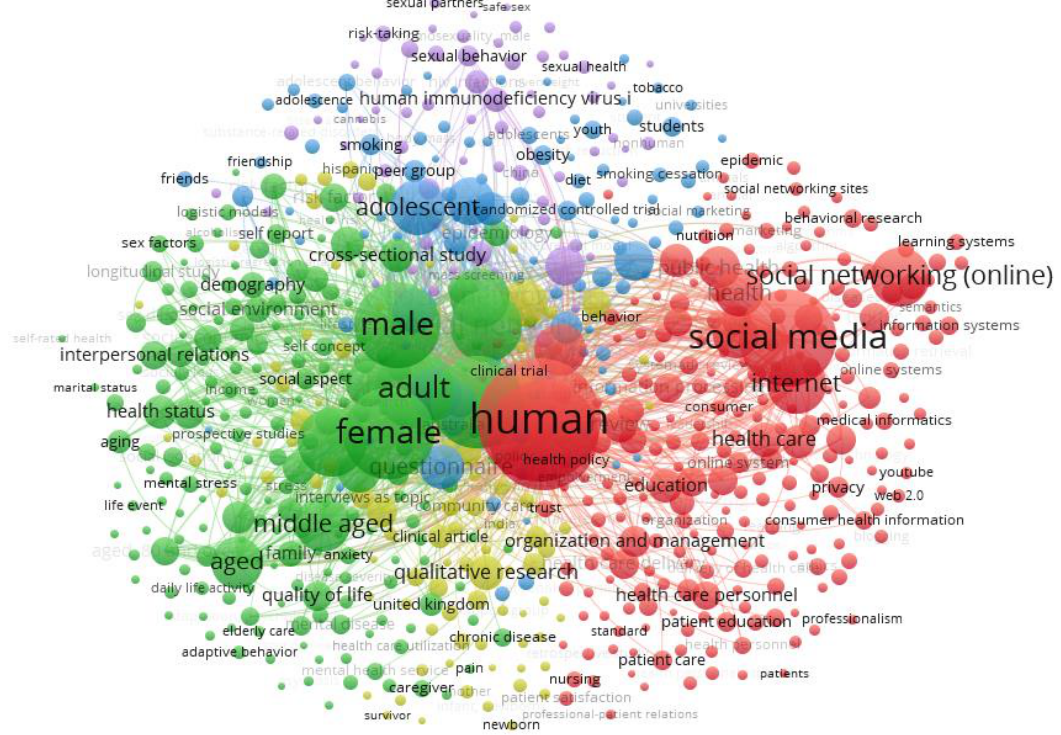
Figure 12. Clusters according to the co-occurrence of keywords. Table 9. Keywords most utilized by the six top communities identified in the topic of social networks related to the health of young people.